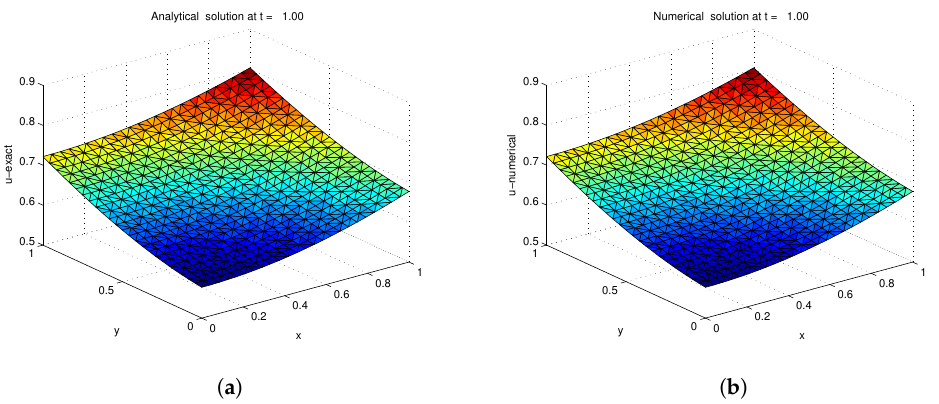
Figure 6. ( a ) Exact against ( b ) numerical solutions, when t = 1, δ t = 0.0001, ns = 20, M = 400 corresponding to Example